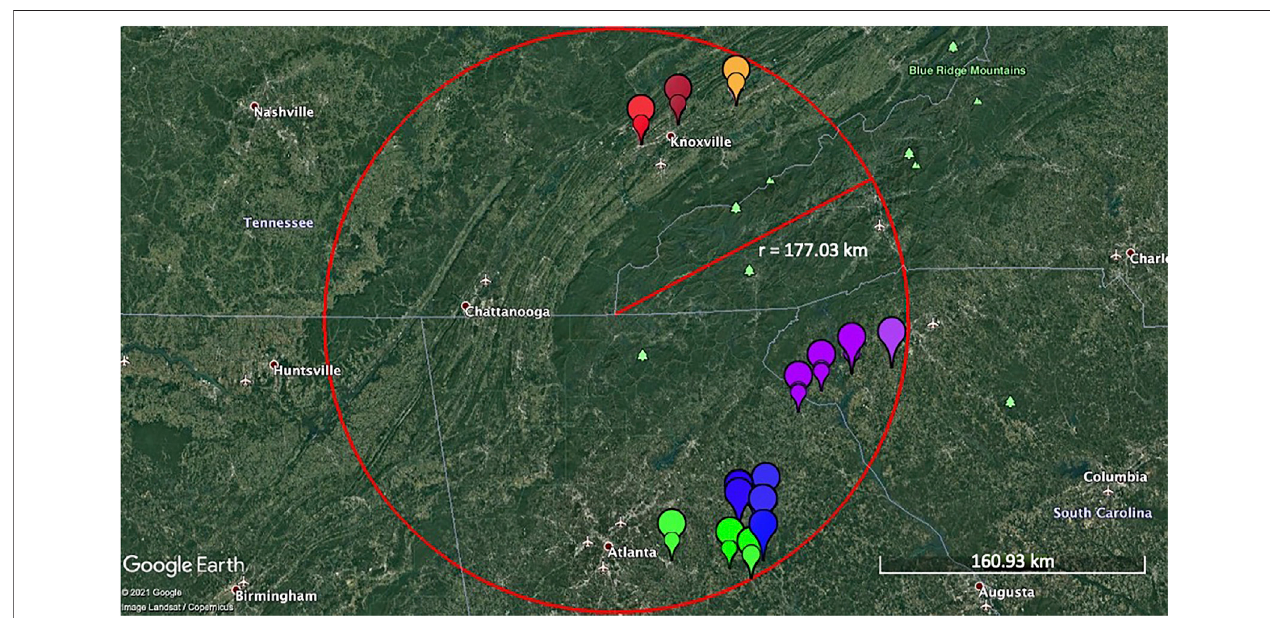
FIGURE 1 | Collection sites of the open-pollinated Pyrus calleryana trees ( n = 180) samples within a ~177 km radius. Each colored symbol represents individual samplestakenfromdifferenttrees.LeafsamplesfromtreeswerecollectedfromTennessee,Georgia,andSouthCarolina,UnitedStates.Eachofthesixcolorsrepresent sixsubpopulations(Brown:NorthGroupA,Red:NorthGroupB,Orange:NorthGroupC,Blue:SouthGroupA,Green:SouthGroupB,andPurple:SouthGroupC).The scale indicates the ground-level distance of ~161 km. The map was generated using Google Earth Pro version